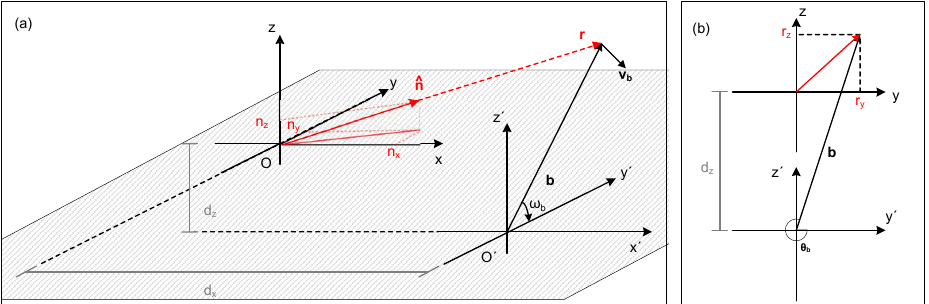
Figure 5. Graphical illustration from ( a ) a perspective and ( b ) a front (looking towards the wind turbine) view of the 𝑥𝑦𝑧 coordinate system used to define the line-of-sight vector r of a radial measurement at any point of a wind turbine blade rotating in the 𝑦 (cid:48) 𝑧 (cid:48) plane when the wind lidar’s pointing direction is aligned to the centre of the rotor (Case